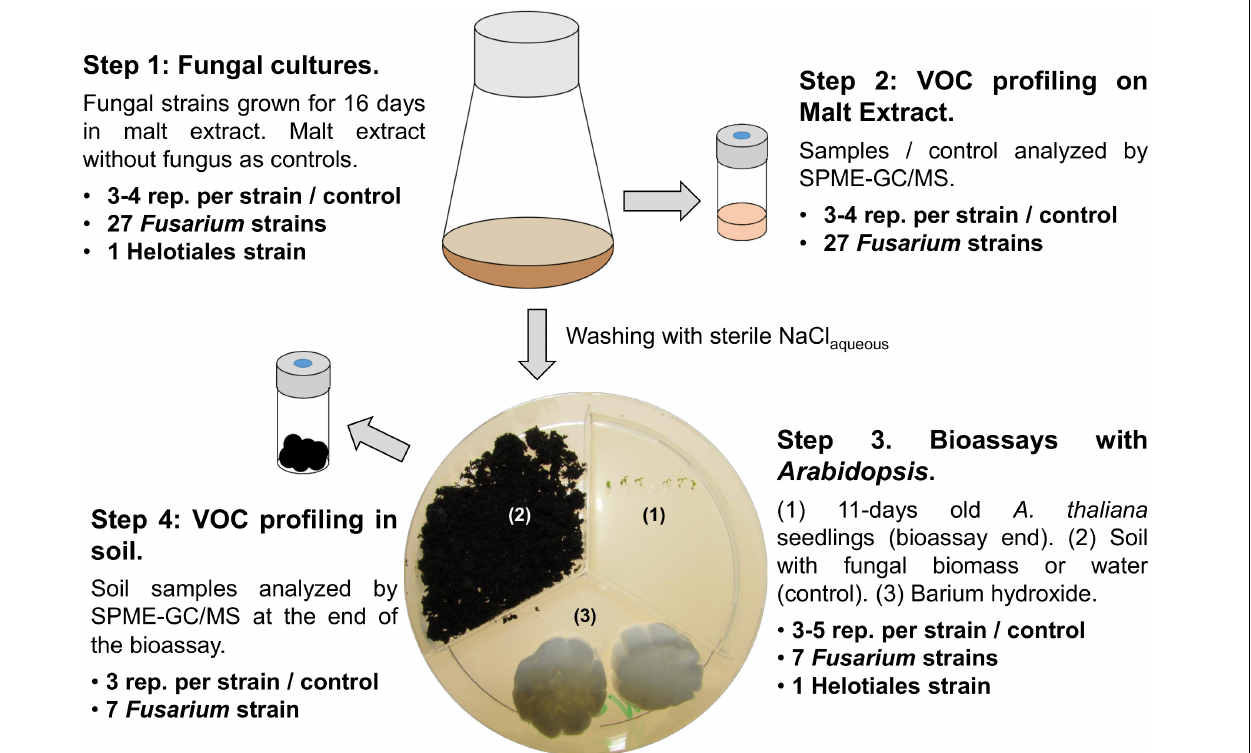
FIGURE 1 | Experimental design. The figure illustrates the four experimental steps as well as the specific fungal strains and numbers of replicates used for each experiment. Step 1: Fungal strains were grown in liquid medium; sterile medium was used as control. Step 2: Fungi were harvested by centrifugation, one part of the mycelium or control medium was analyzed by GC/MS, one part was used to inoculate sterilized soil for the bioassays (step 3). Bioassay setup: six seeds of A. thaliana were grown exposed to VOCs released from the soil compartment. Plant morphology was determined at the end of the experiment and soil samples were analyzed by GC/MS (step